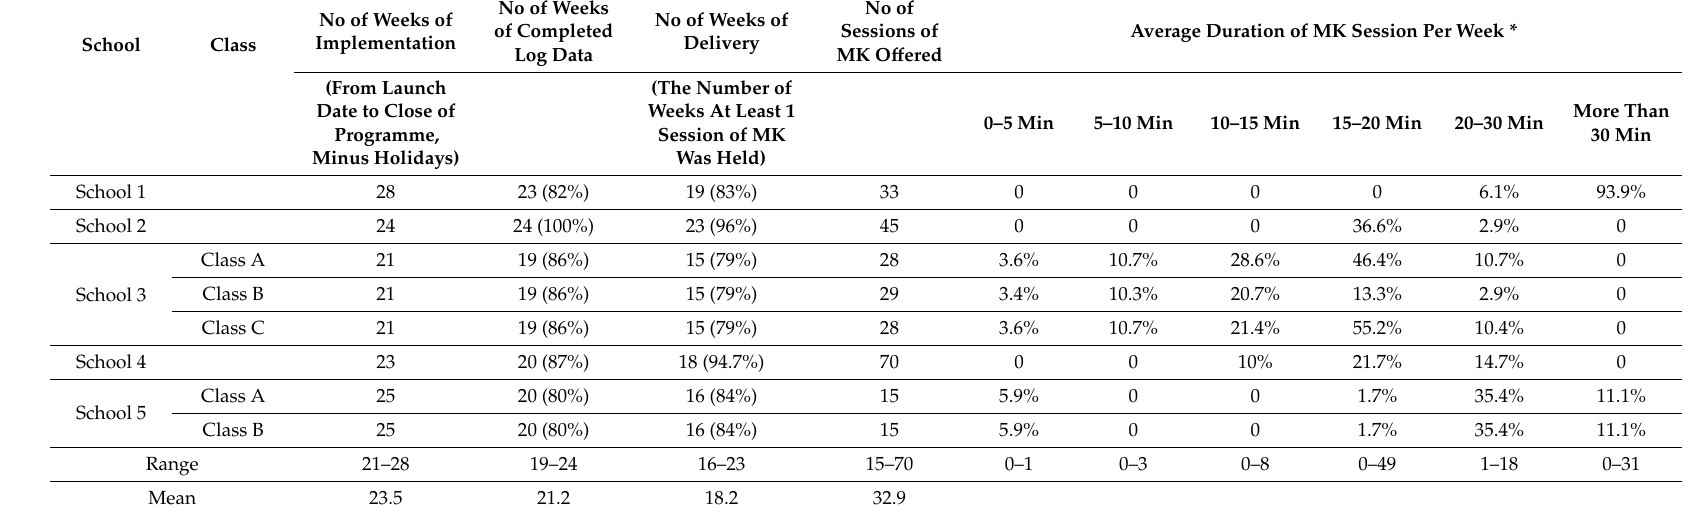
Table 5. Dose of Marathon Kids (MK) delivered (based on teacher implementation log